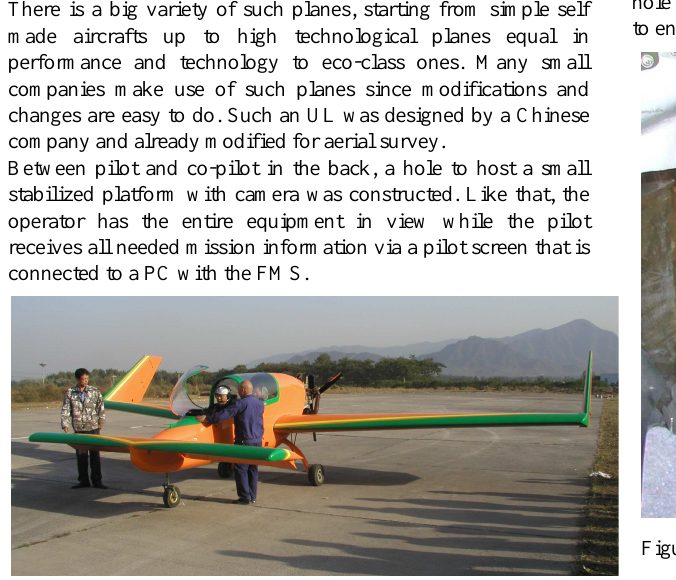
Figure 7: design of a „Duckwing“ ultra light aircraft of a